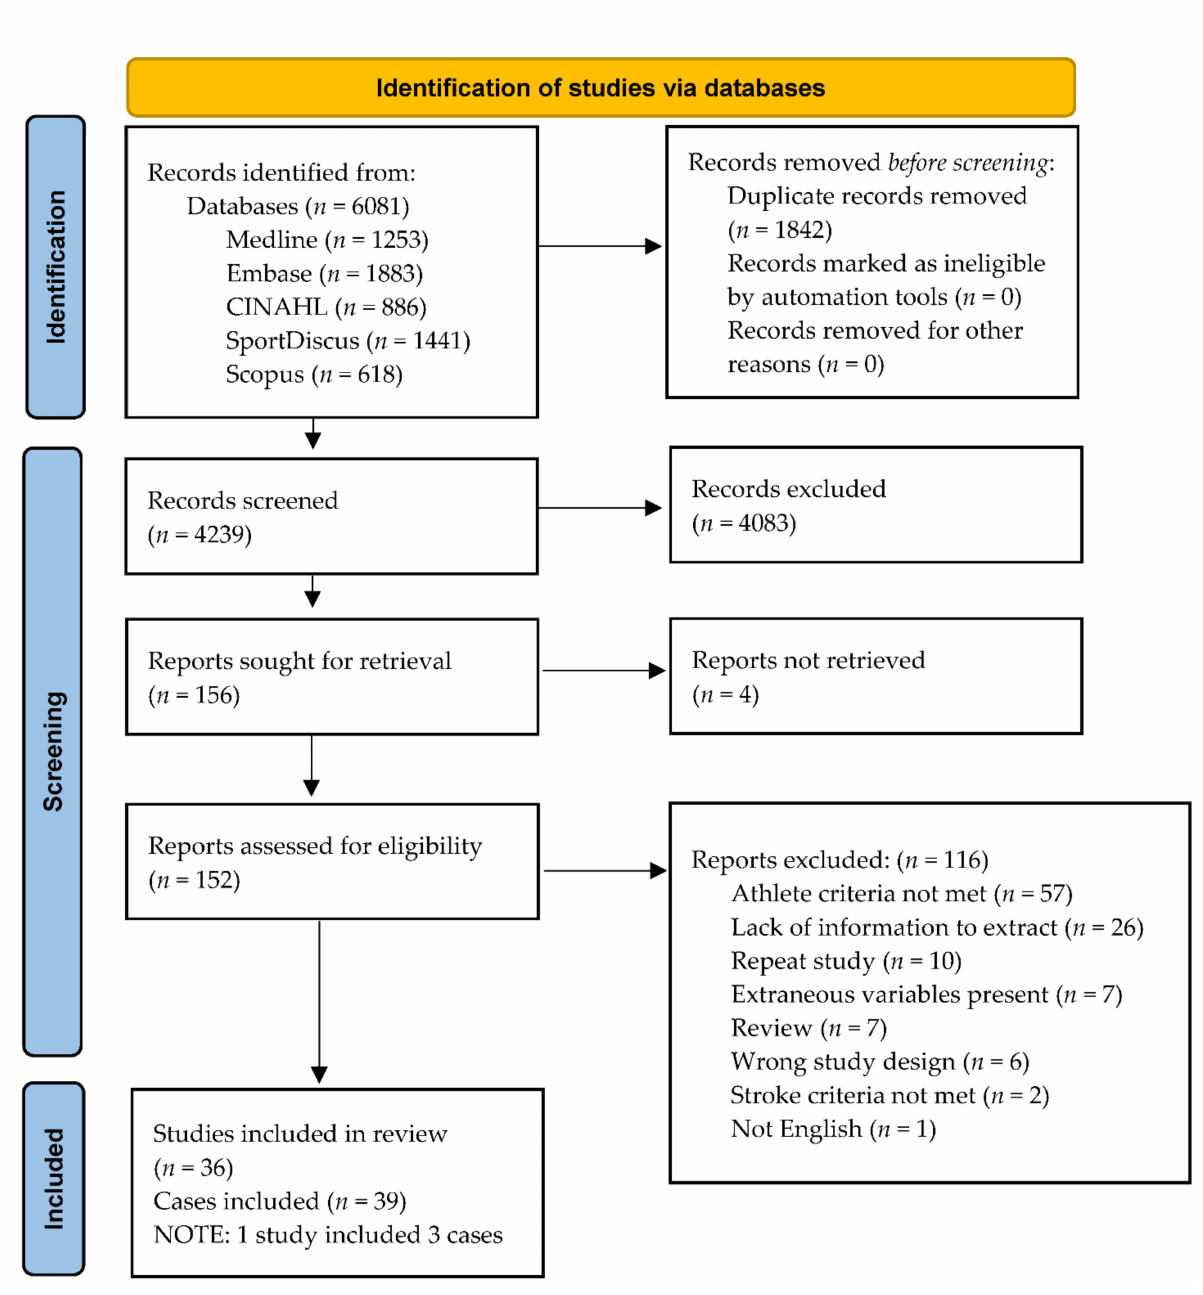
Figure 1. Screening of records on stroke in athlete. Page, M.J.; McKenzie, J.E.; Bossuyt, P.M.; Boutron, I.; Hoffmann, T.C.; Mulrow, C.D.; et al. The PRISMA 2020 statement: An updated guideline for reporting systematic reviews. BMJ 2021 , 372 , n71, doi:10.1136/bmj.n71. For more information, visit: http://www.prisma-statement.org/ (accessed on 11 September